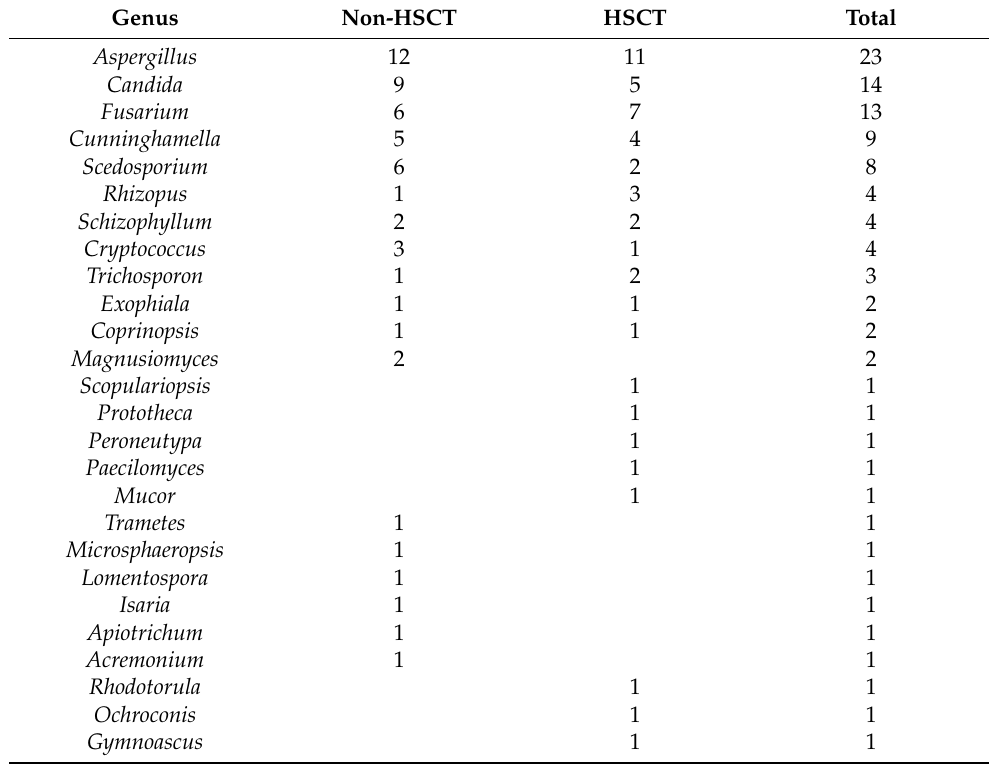
Figure 2. Clinical specimens in this study. Table 3. Causative fungi of IFD in patients with haematological disorders (genus